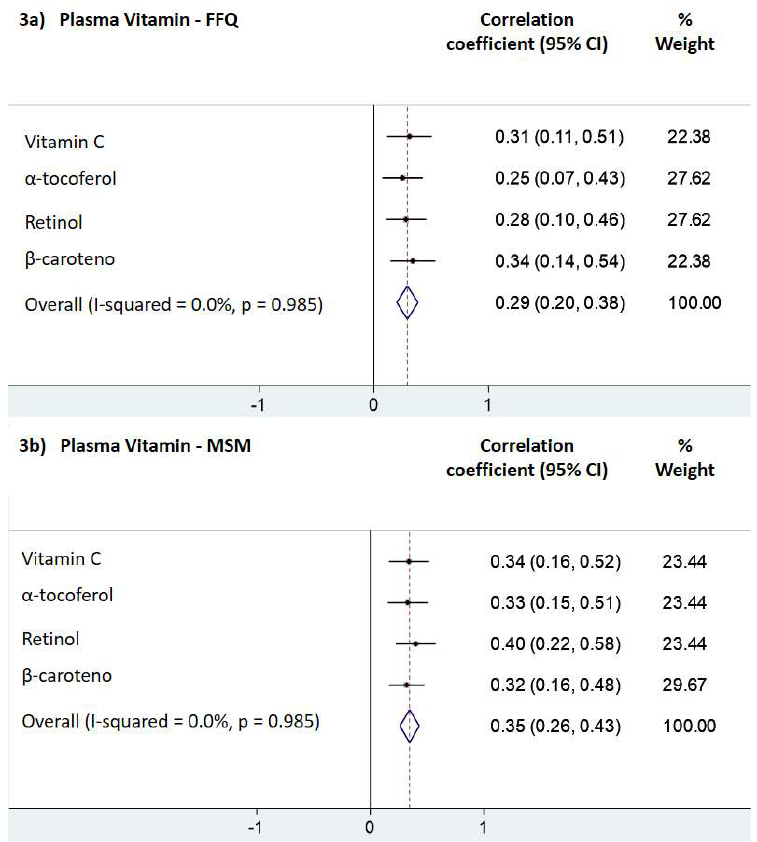
Figure 3. 95% CI: 95% Confidence interval; FFQ: Food frequency questionnaire; MSM: Multiple source method (the combination of frequency of intake with 3 days of 24-h Dietary Recall). ( a , b ) Correlation coefficients from multiple linear regression for children’s (6–10 years) fruit and vegetable intake estimated by the FFQ versus plasma vitamins ( a ); the MSM versus plasma vitamins ( b ).